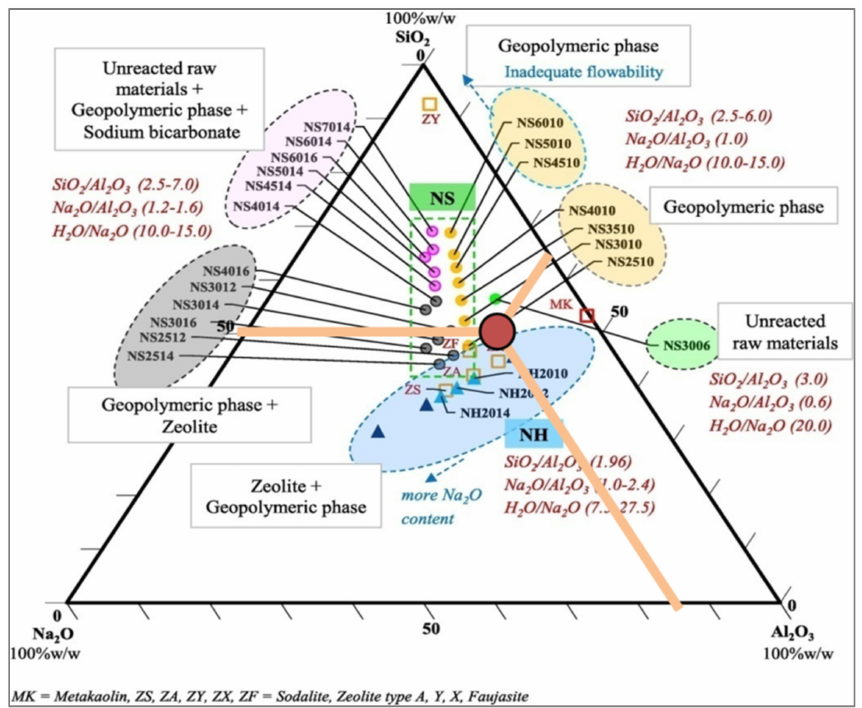
Figure 13. Ternary mixed design composition of geopolymer pastes with different ratios of SiO 2 /Al 2 O 3 , Na 2 O/Al 2 O 3 , and Na 2 O/SiO 2 from the article prepared by Juengsuwattananon et al. [64] with own mixture